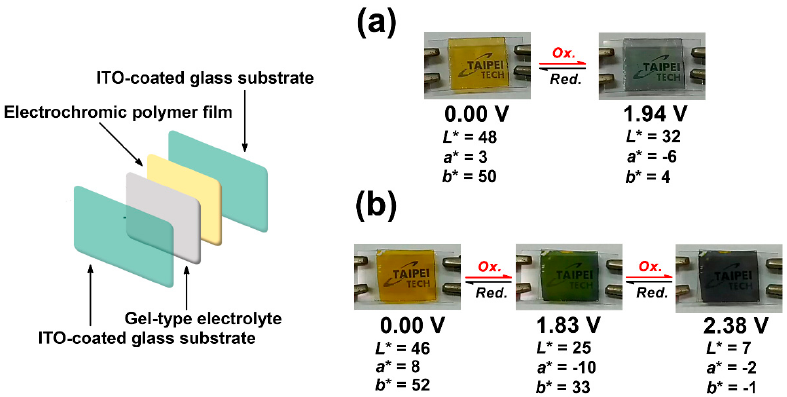
Figure 13. Photos of sandwich-type ITO-coated glass electrochromic devices using ( a ) P1 and ( b ) P2 films as active layers (active area ca. 20 mm × 20